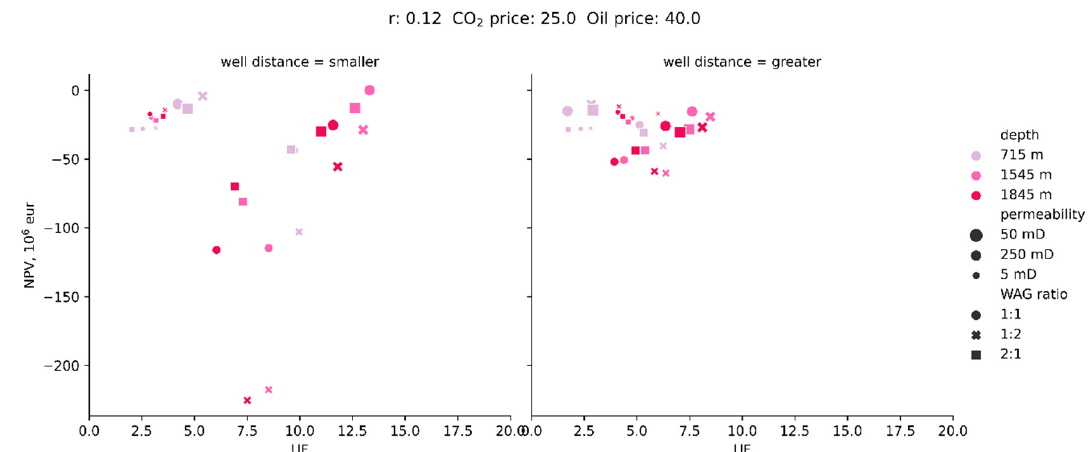
Figure 12. Net present value (NPV) versus UF for the realistic scenario at the end of EOR with 40 €/MWh electricity price.